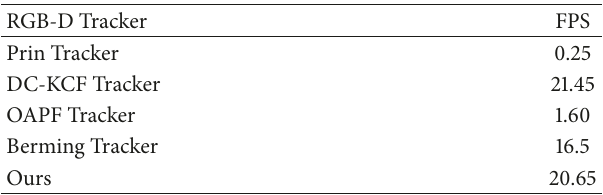
Table 2: The average running speed comparison